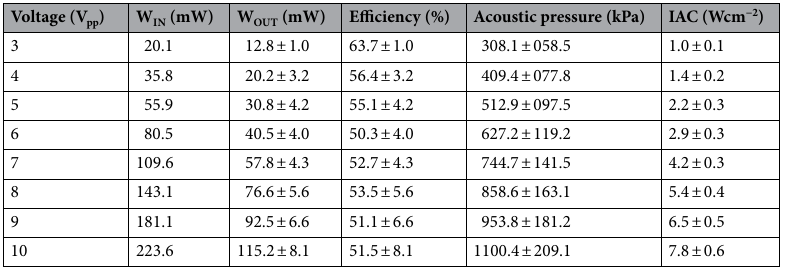
Table 2. Output parameters of the miniature focused ultrasound transducer used for the in vivo capsule.